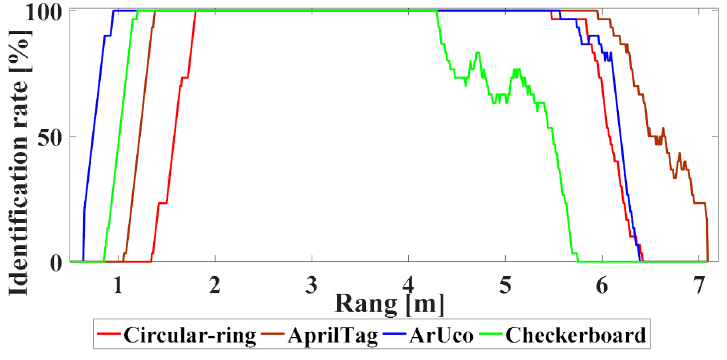
Figure 8. The marker identification rate versus